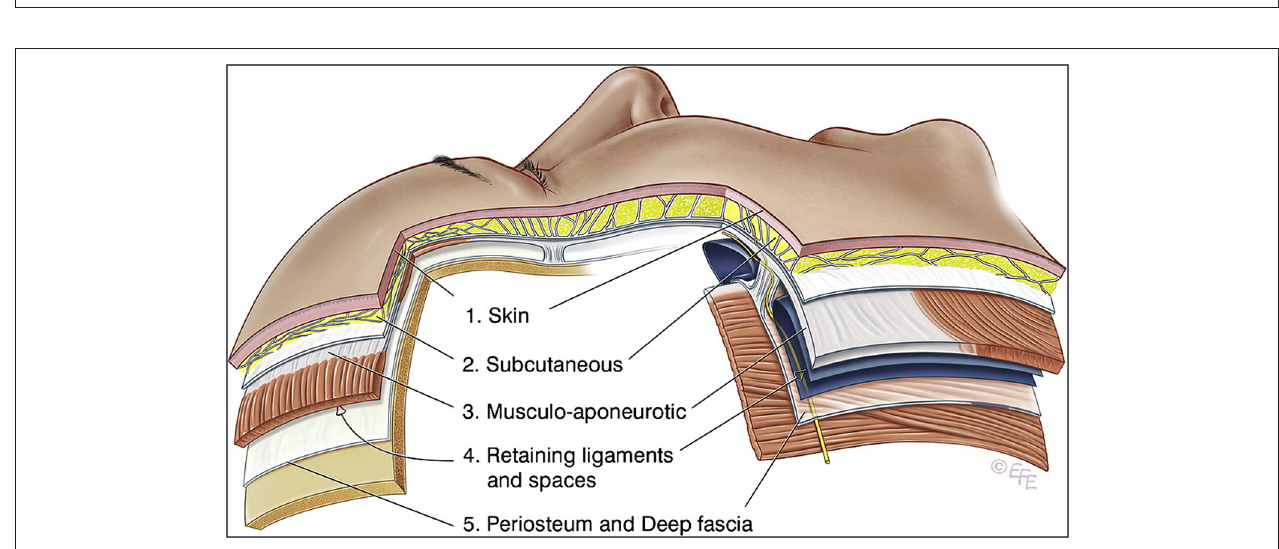
FIGURE 2 | Layer model diagram of facial tissues. Adapted with permission from Mendelson et